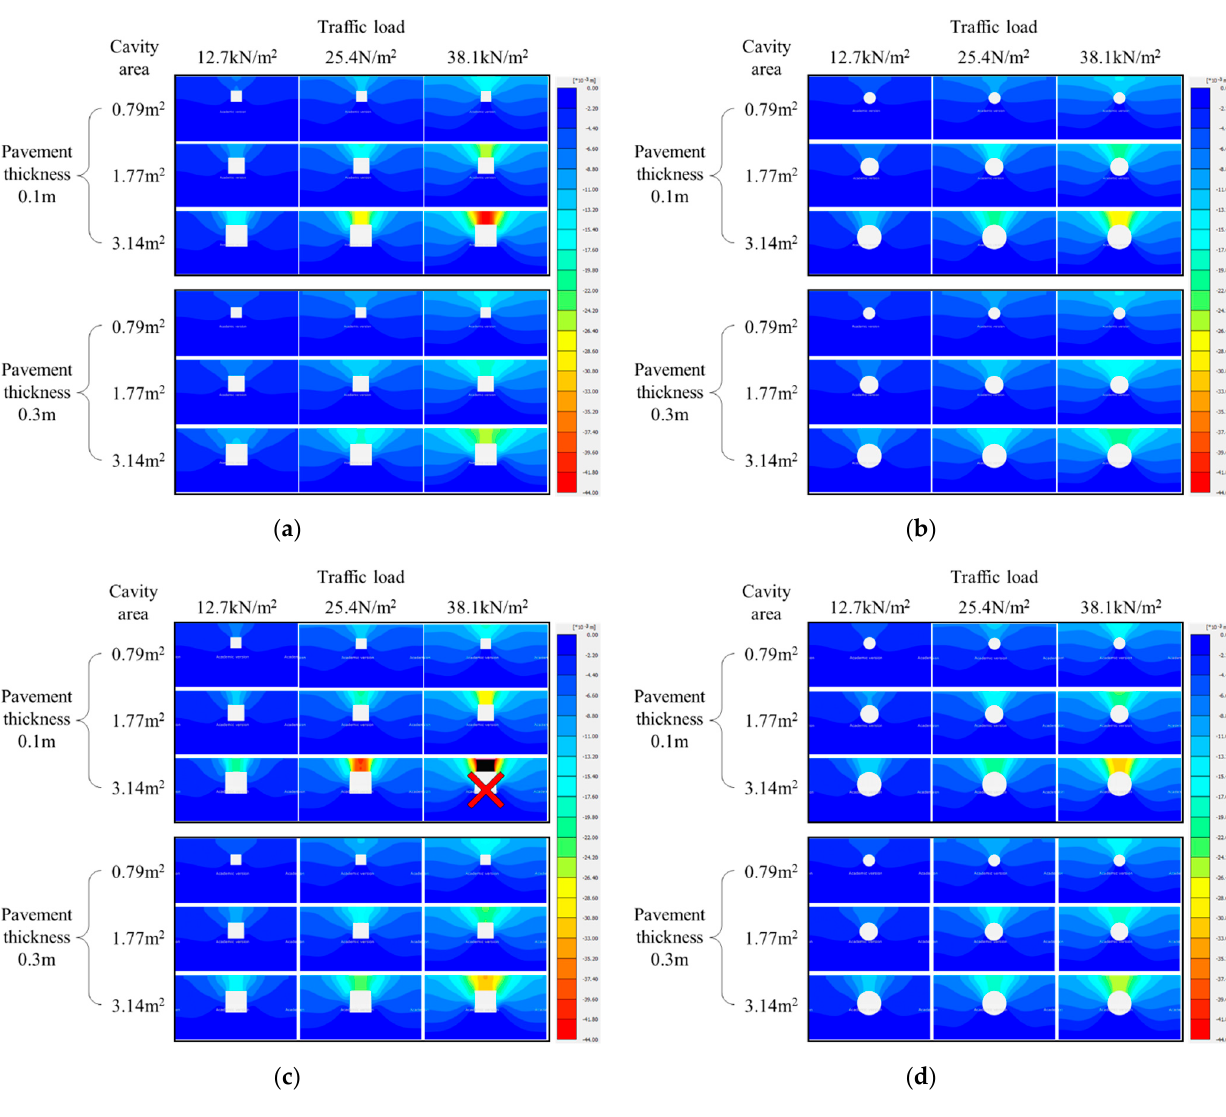
Figure 6. Vertical displacement distribution. ( a ) Rectangular cavity (3000 MPa); ( b ) circular cavity (3000 MPa); ( c ) rectangular cavity (500 MPa); ( d ) circular cavity (500 MPa).